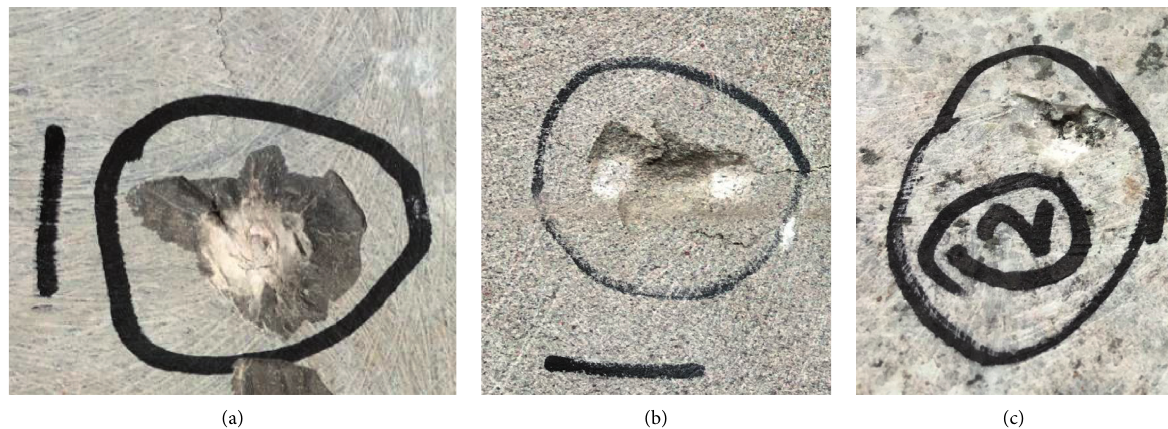
Figure 12: Breaking holes of the flat rock sample under impact: (a) sandstone; (b) limestone; (c) granite.